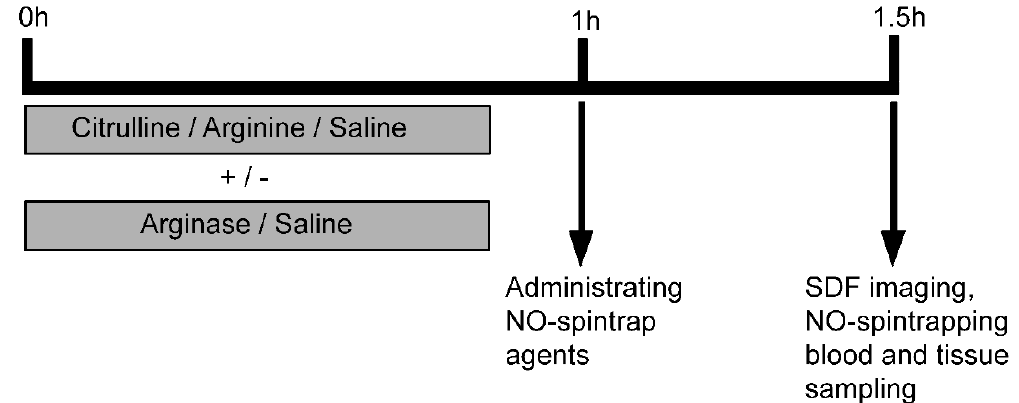
Figure 1. Experimental setup of the acute arginase model. Mice received an intraperitoneal injection with sterile saline or arginase combined with L -citrulline or L -arginine at time zero ( t = 0 h). After 1 h ( t = 1 h), mice received either spin-trap agents to measure the nitric oxide (NO) production in vivo or a sterile saline injection as placebo treatment. After 1.5 h ( t = 1.5 h), side stream dark-field (SDF) imaging was used to quantify the microcirculation in the jejunal villi or organs were harvested to determine the formed iron-diethyldithiocarbamate (DETC) complexes as a parameter for the NO production in vivo . At the end of the experiment, blood and tissue samples were harvested for amino acid